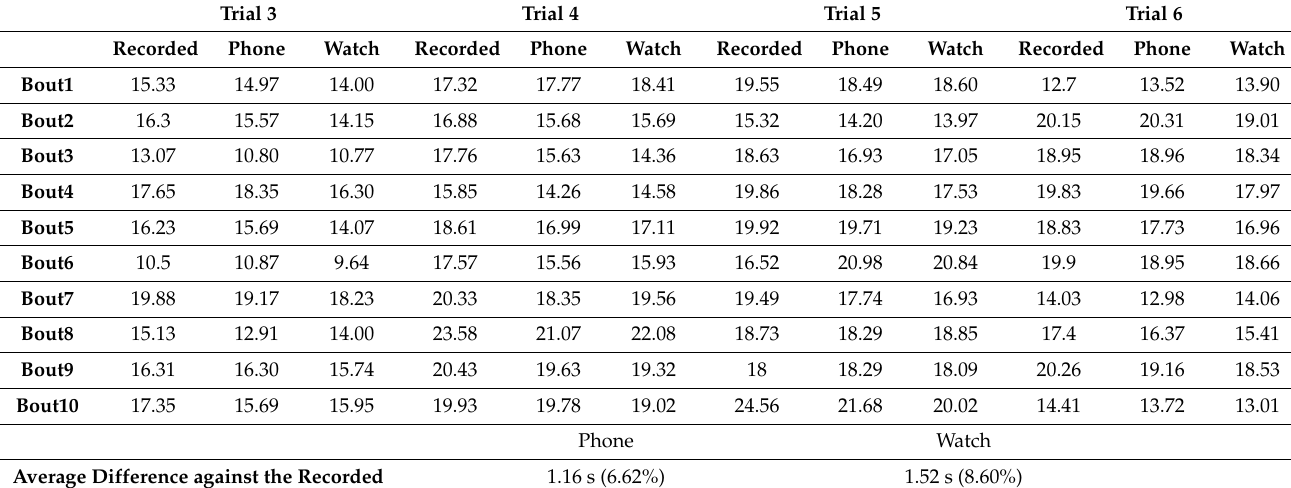
Table 3. Pairwise correlation for the first experimental series. Recorded Phone Watch Recorded